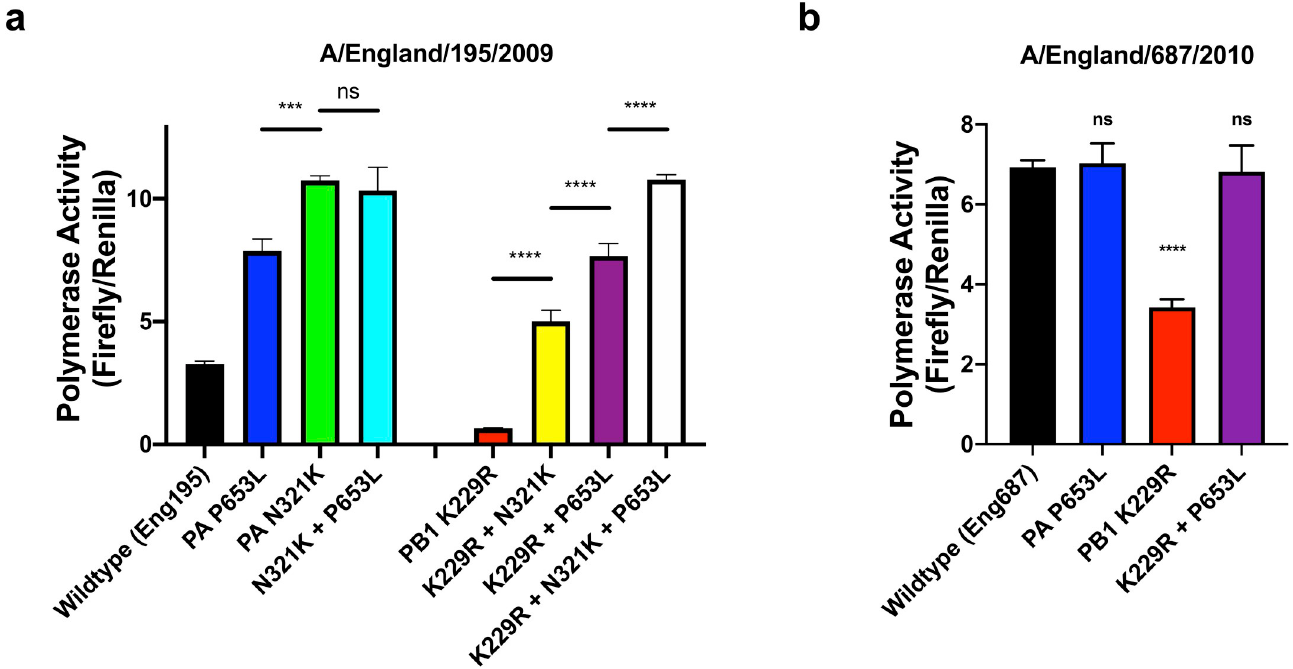
Fig 4. Minigenome assays were performed in 293T cells in 24 or 48-well plates. For 24 well plates, Pol I–firefly luciferase minigenome reporter, at 0.08 μ g and PCAGGS-Renilla, at 0.1 μ g were transfected with PCAGGS plasmids coding for wildtype and mutated polymerase subunits (PB1, PB2 and PA) and NP at 0.08, 0.08, 0.04 and 0.12 μ g respectively derived from A) Eng195 first wave and B) Eng687 third wave pH1N1 virus. Plasmid amounts were halved for 48-well plate experiments. Luciferase signal was read 24 hours post-transfection. Polymerase activity is given as a ratio Firefly to Renilla signals. One-way ANOVA with Dunnett’s multiple comparison test, ��� p < 0.001, ���� p < 0.0001, ns = not significant. N = 3. Error bars show s.d. Experiments were repeated 3 times and a representative experiment is shown.